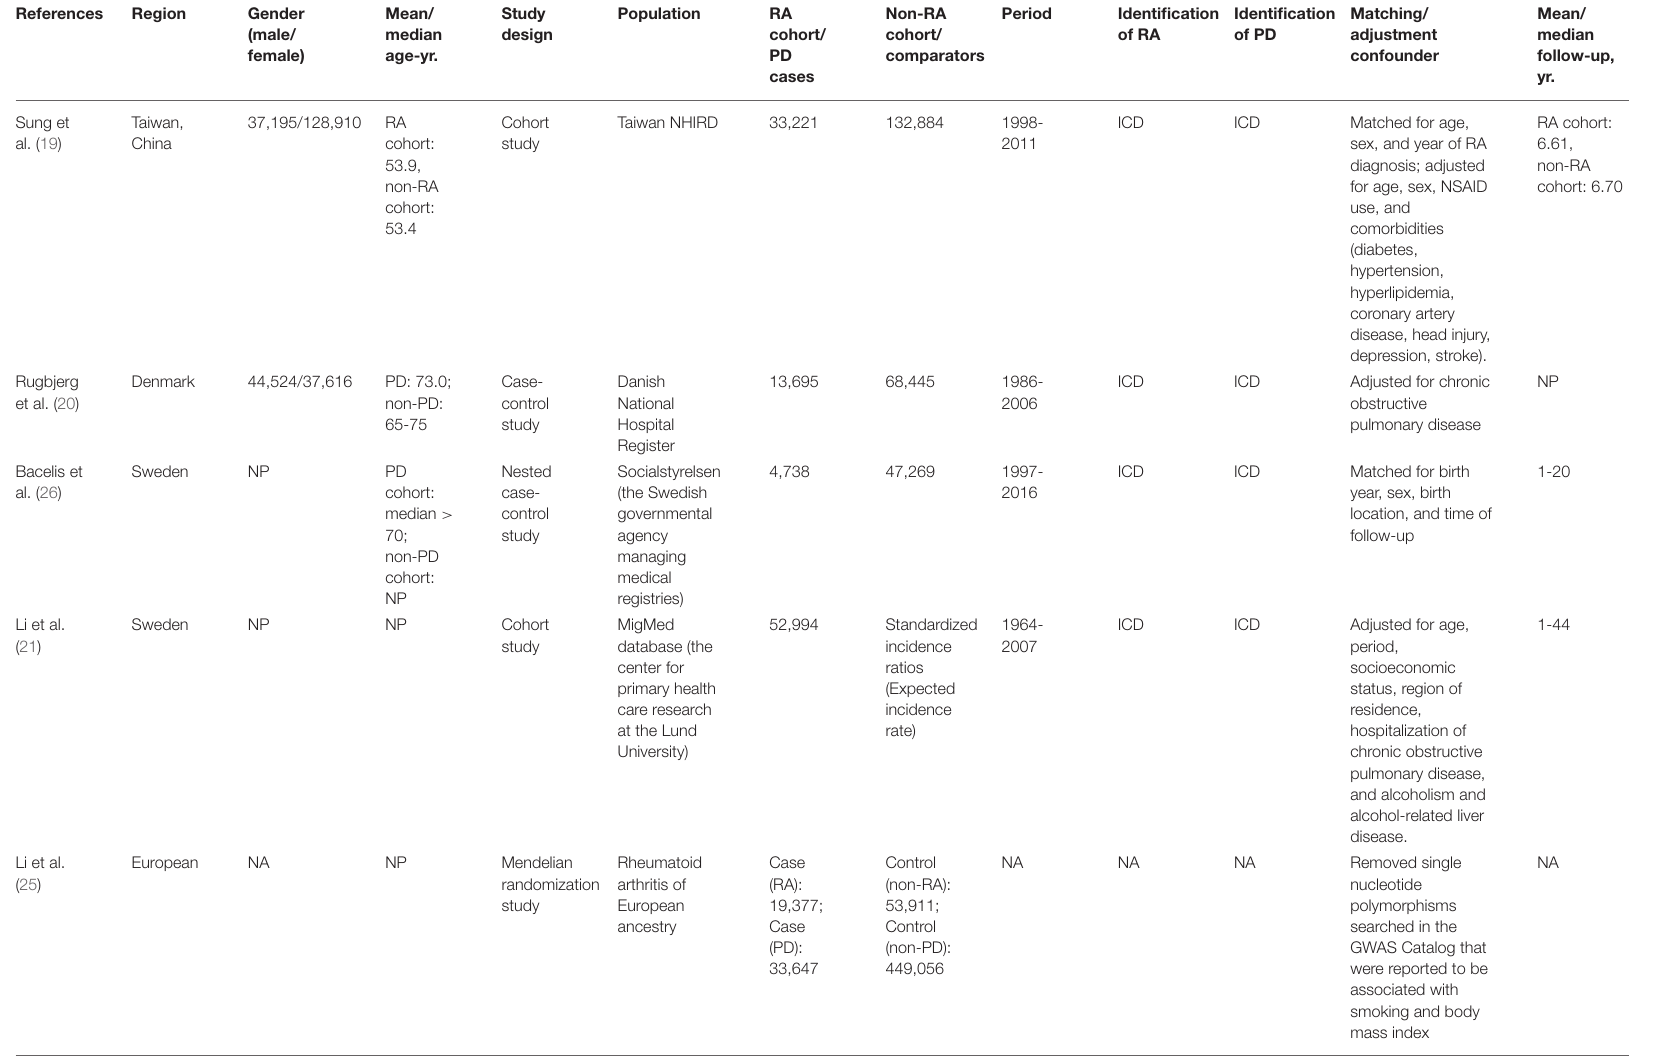
TABLE 1 | Characteristics of included